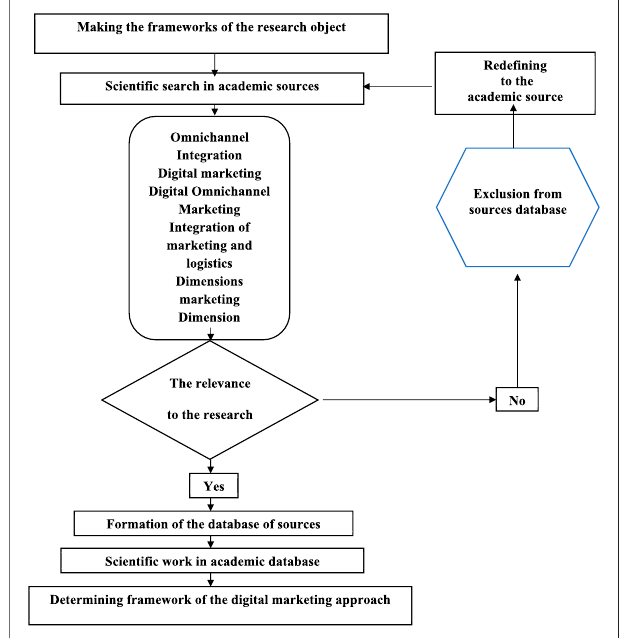
FIGURE 1 | Digital omnichannel marketing